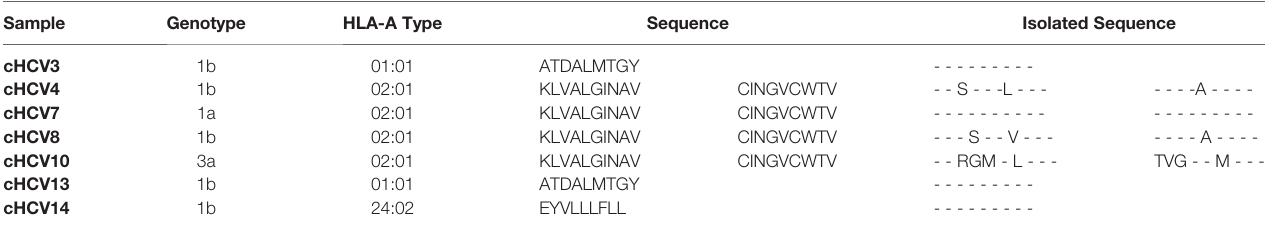
TABLE 3 | Analysis of the circulating viral